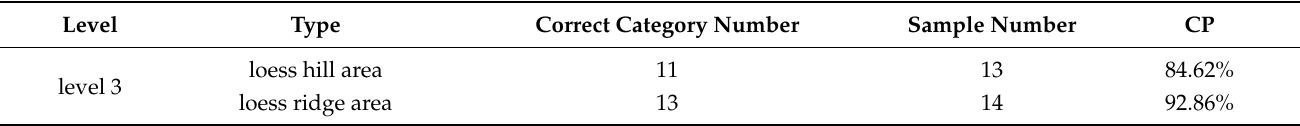
Table 6. Statistical results of the third level precision rate of the loess hill and loess ridge